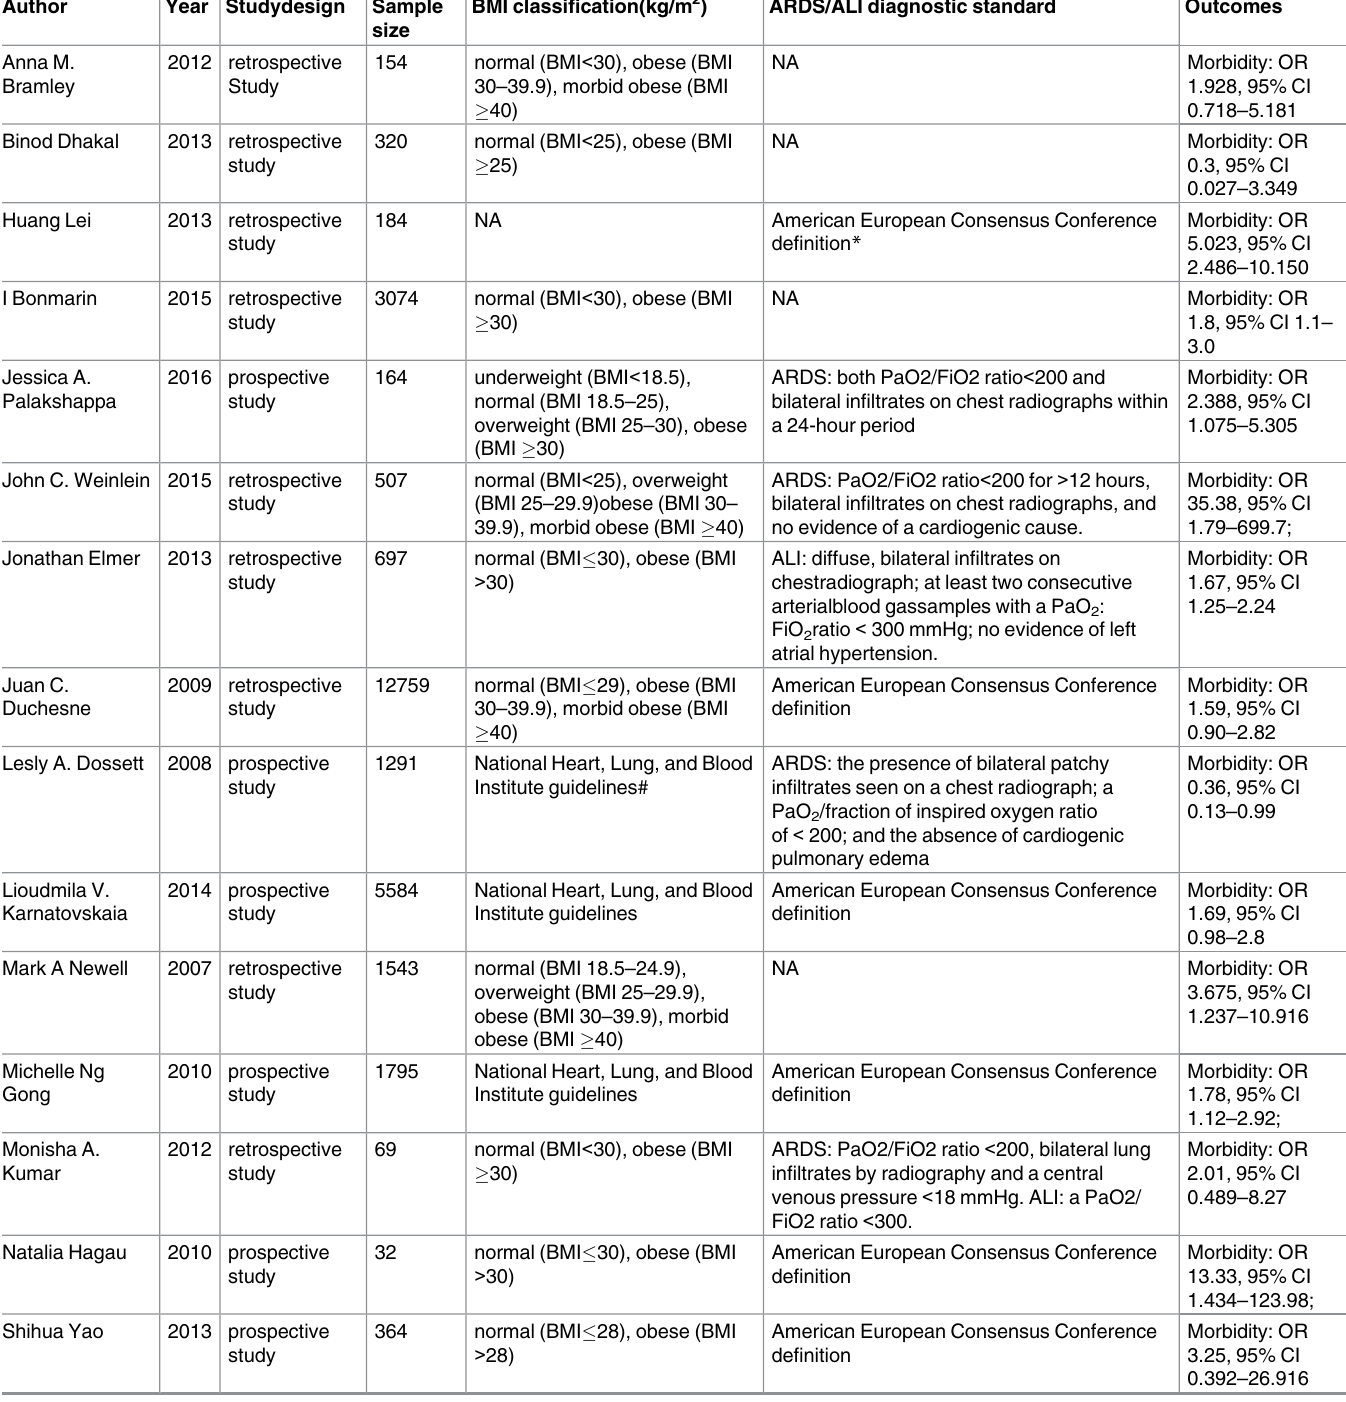
Table 1. Characteristics of included studiesthat examined the effect of obesityonmorbidity of